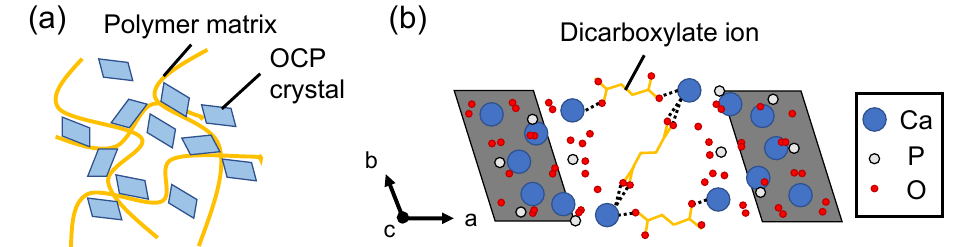
Figure 4. Illustration of hybrid states of ( a ) OCP/polymer complex to improve the shaping and enhancing bone regeneration and ( b ) OCPC to provide the selective adsorption and catalysis. The hydrogen phosphate ions in the hydrated layer of OCP can be replaced with Table 1. Interlayer distances of OCPC hybridized with various dicarboxylate ions. formation (Figure 4b) [78]. The substitution of linear, various side chain, unsaturated